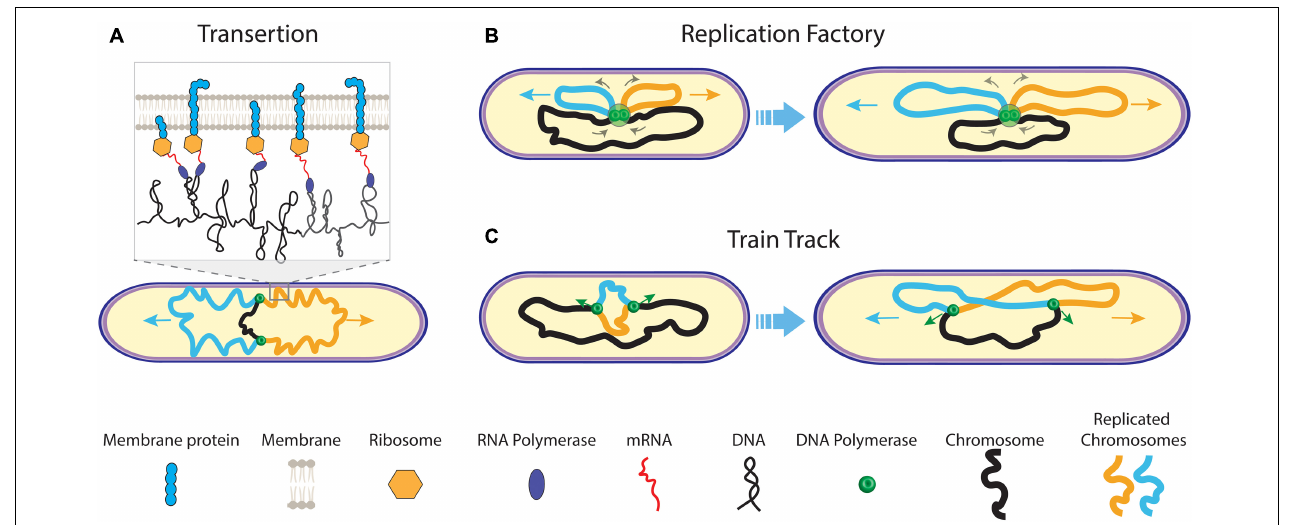
FIGURE 2 | Early models of prokaryotic DNA segregation. (A) The transertion model. During replication of the mother chromosome (black) by the replisomes (green dots), co-translational transcription of membrane protein mRNA leads to tethering of the sister chromosomes (orange and blue) to the cell membrane. As genes on one chromosome are biased in their position relative to genes on the other chromosome, a transertion area forms on the cell membrane for each sister (inset). Both transertion areas move in opposite direction on the elongating cell membrane. (B) The replication factory model. During replication, centrally fixed replisomes extrude replicated sister chromosomes (orange and blue) toward the cell pole, concomitantly pulling the yet un-replicated mother chromosome (black) inward. (C) The train track replication model. The two replisomes independently act on and move along the separate chromosome arms during replication. Their position in the cell is determined by the localization of the to-be copied genetic